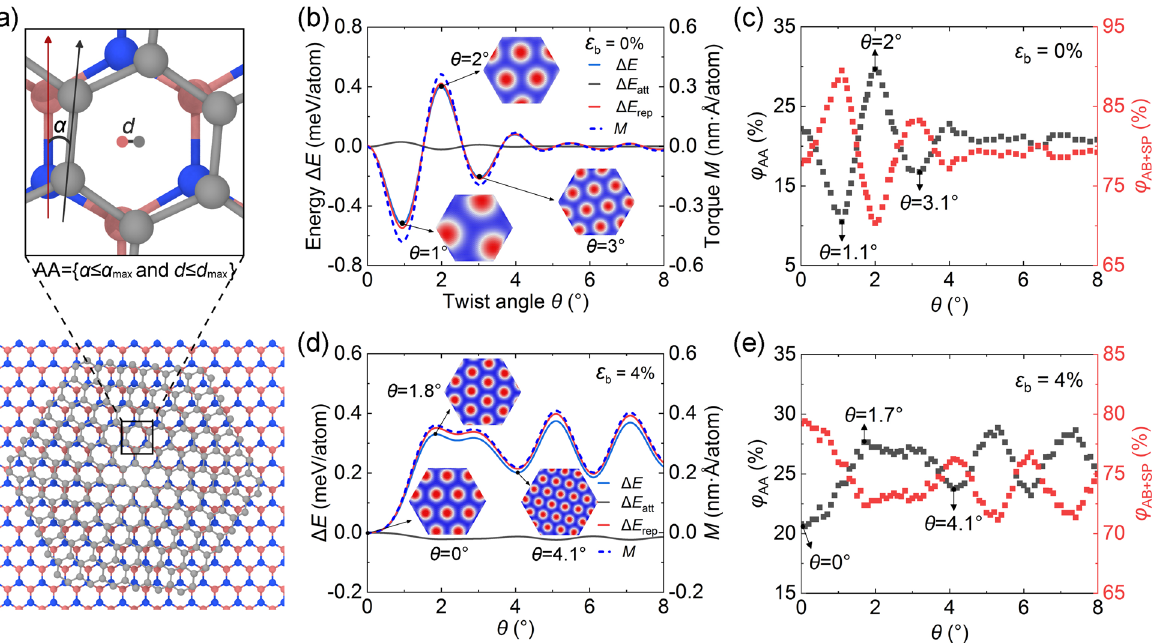
Figure 4. Correlation between stacking modes and interlayer energy. ( a ) Schematic of the AA mode. d represents the distance between the centroids of two lattices, and α denotes the orientation difference. When d < d max and α < α max , the interface lattice is considered to be in the AA mode. Here, d max = 0.5 Å and α max = 8°. By calculating the lattice one by one, we can get the proportion of the AA mode in the entire flake. ( b , d ) Variation of the interlayer energy (Δ E ) modulated by heterostrain. Δ E has been decomposed into the attractive (Δ E att ) and repulsive (Δ E rep ) components. The rotational torque is calculated by M = ∂ E / ∂θ . Insets show the evolution of the AA (red) and AB + SP (blue) modes. ( c , e ) Ratios of different stacking modes versus θ . φ AA and φ AB+SP represent the ratio of AA and AB + SP stacking modes, respectively. Arrows indicate local maxima and